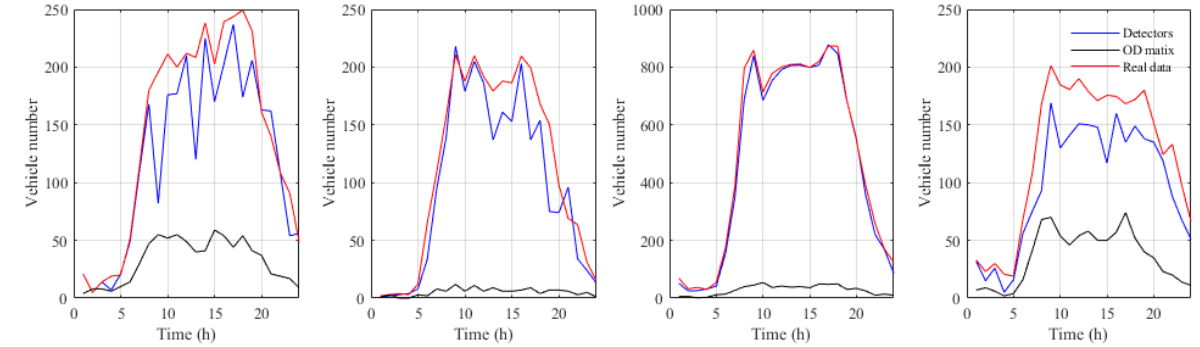
Figure 5. Traffic volume of the verification points. (Red lines, real data; blue lines: simulation of intersection loops data; black lines: simulation of OD matrix data).